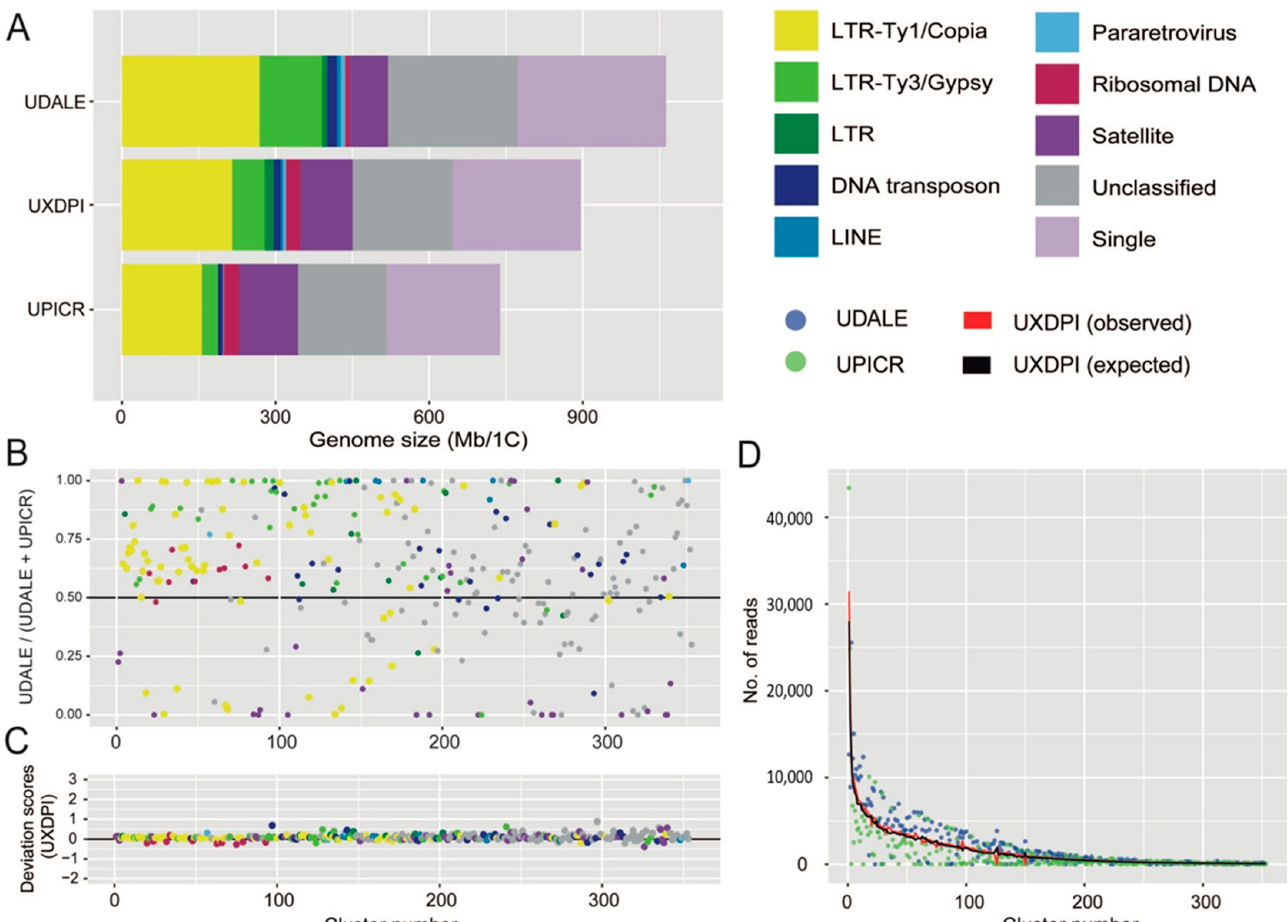
Figure 3. ( A ) Genomic composition of Urospermum dalechampii (UDALE), U. dalechampii × U. picroides (UXDPI) and U. picroides (UPICR). Estimates of the genomic abundances (in Mb/1C) of different repeats are colored by repeat class. The size of the unclassified (grey) and low/single copy fraction (pale purple) of each genome is also shown. ( B ) Comparison of cluster abundances in the parental species U. dalechampii and U. picroides , irrespective of cluster size. Read clusters falling along the black line (i.e., value of 0.5) have the same proportion in both species. Those above the 0.5 are more abundant in U. dalechampii and those below this threshold are more abundant in U. picroides . ( C ) Deviation scores of observed cluster sizes from the expected values in the putative hybrid (UXDPI). Clusters above and below 0 line represent larger and/or smaller values than the expected values from parents. ( D ) Scatter plot of genomic contributions (read clusters) of U. dalechampii (blue dots) and U. picroides (green dots) to the hybrid U. dalechampii × U. picroides (red line) and the expected values calculated assuming a 50% genome dosage (black line).